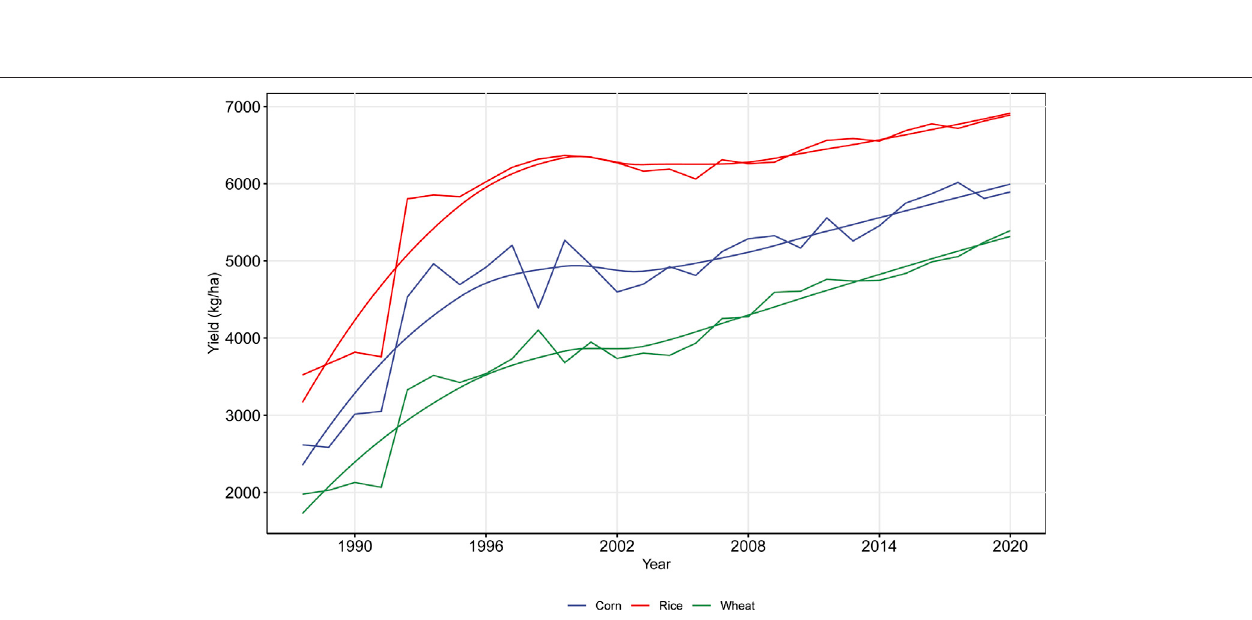
Frontiers in Environmental Science |